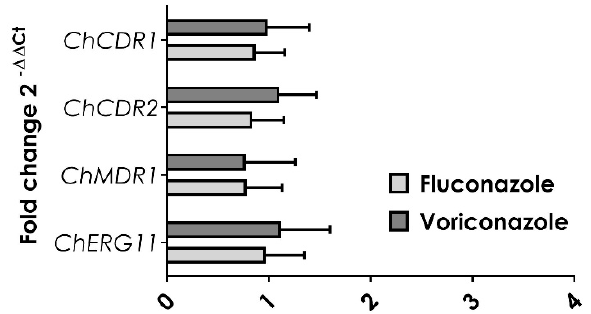
Figure 3. Expression of the CDR1 , CDR2, MDR1 , and ERG11 genes in C. haemulonii . The expression of target genes was determined by RT-qPCR in the clinical isolate of C. haemulonii LIP Ch 4. A pre-treatment was conducted 1.5 h earlier with fluconazole (FLC at 64 mg / L) and voriconazole (VRC at 16 mg / L) before the RNA extraction. Actin gene ( ACT1 ) was used as a housekeeping gene. The results were expressed as the mean ± standard deviation of three independent experiments.